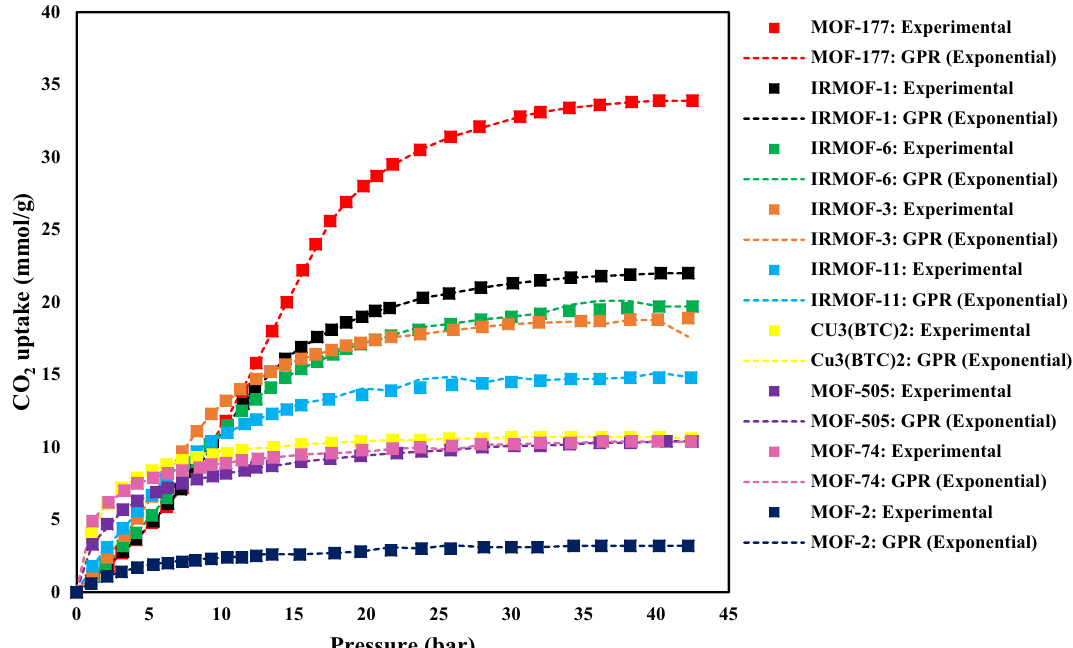
Figure 6. The CO 2 adsorption capacities of different MOFs at 298